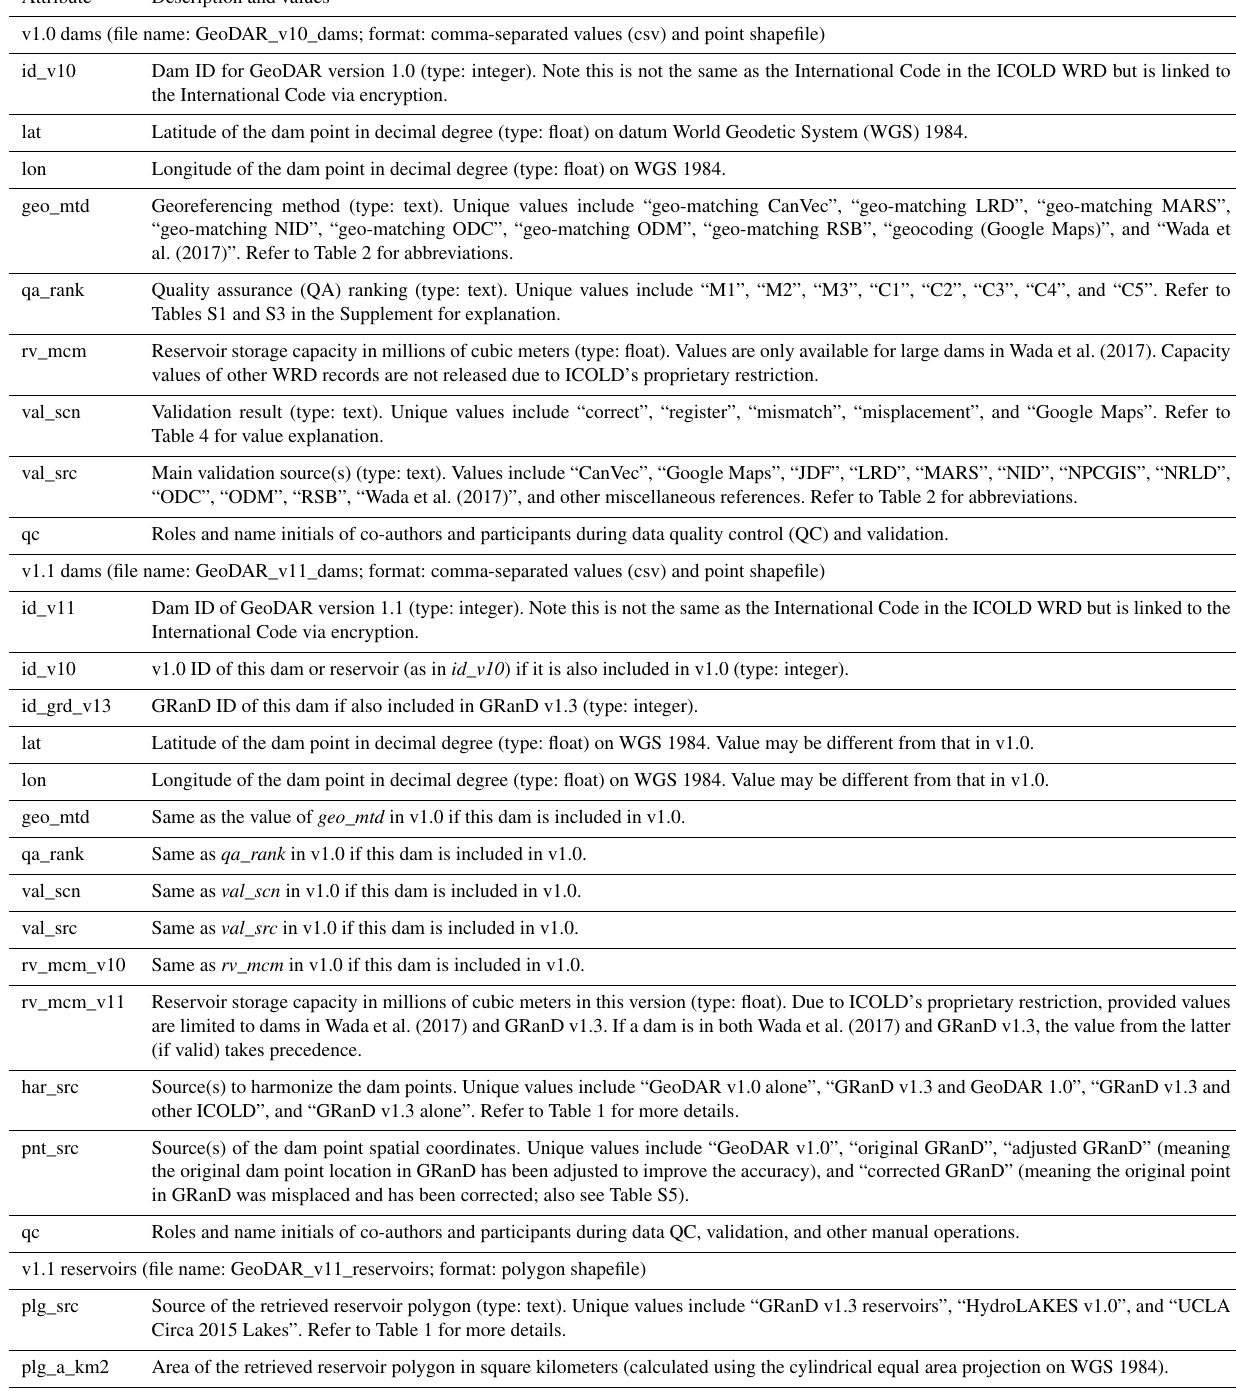
Table 3. Attributes in the data products of GeoDAR. Attribute Description and